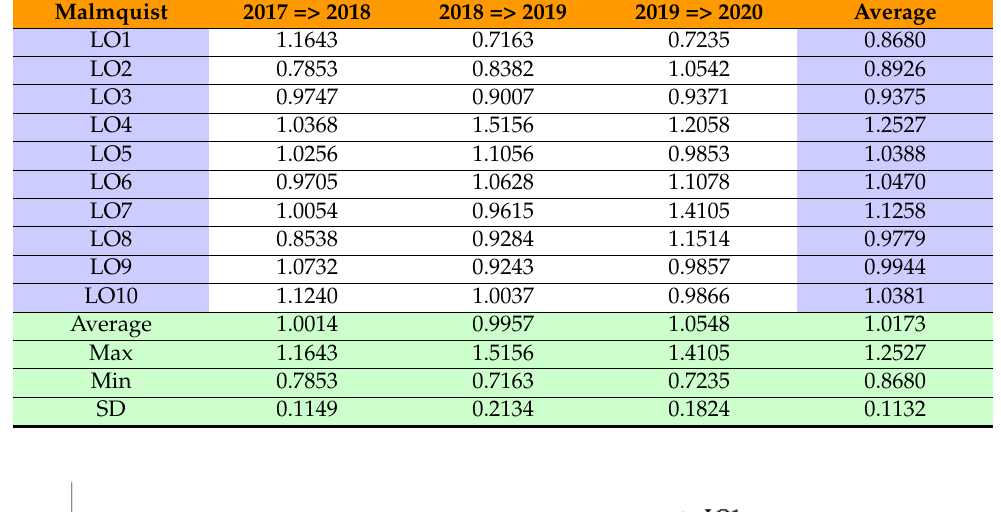
Table 7. Malmquist results (calculated by researcher).